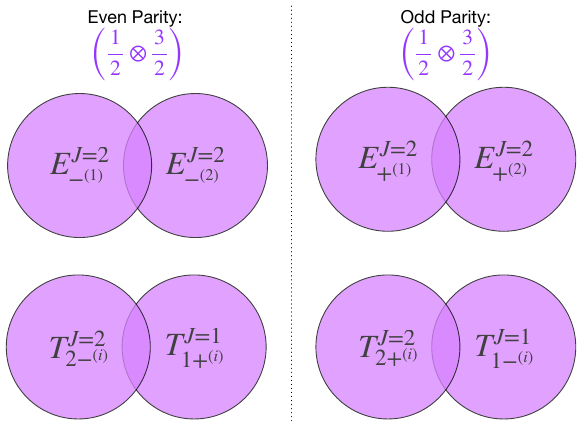
⊗ 3 electrons, with 2 2